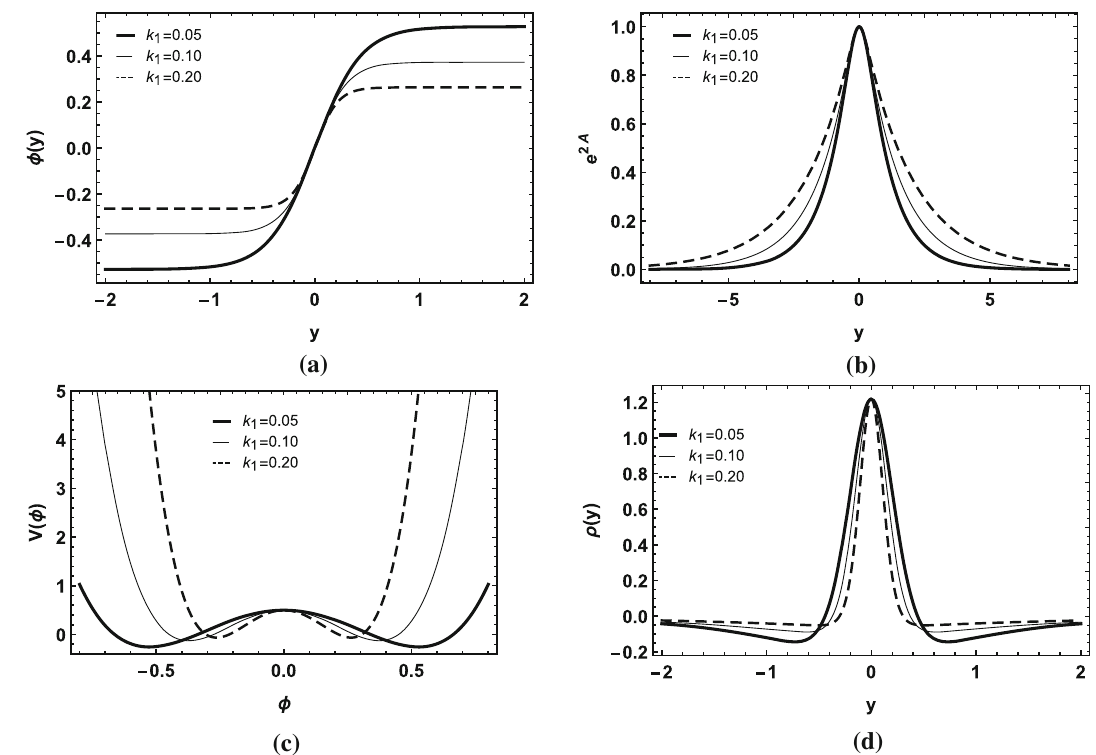
Fig. 5 Plots of the kink solution ( a ), warp factor ( b ), potential ( c ), energy density ( d ), where k 2 = 0 . 5 and α = β =